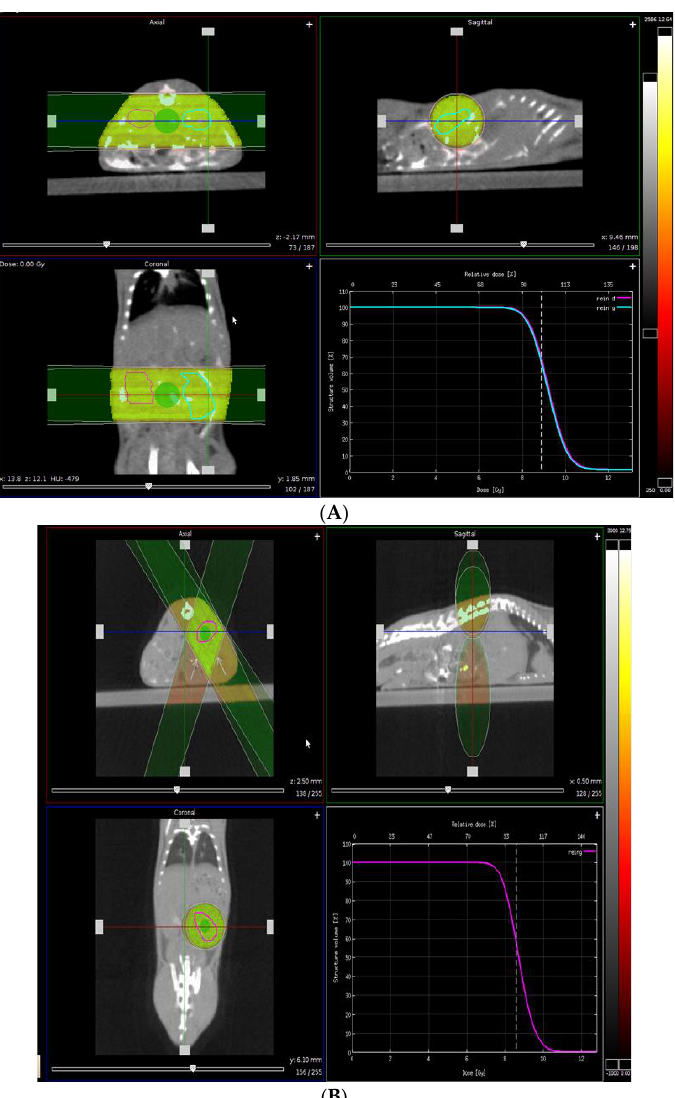
Figure 3. PXi X-Rad SmART renal radiation therapy: ( A ) bilateral renal irradiation with two beams of X-rays targeting both kidneys and ( B ) unilateral renal irradiation with three beams of X-rays targeting the left kidney.